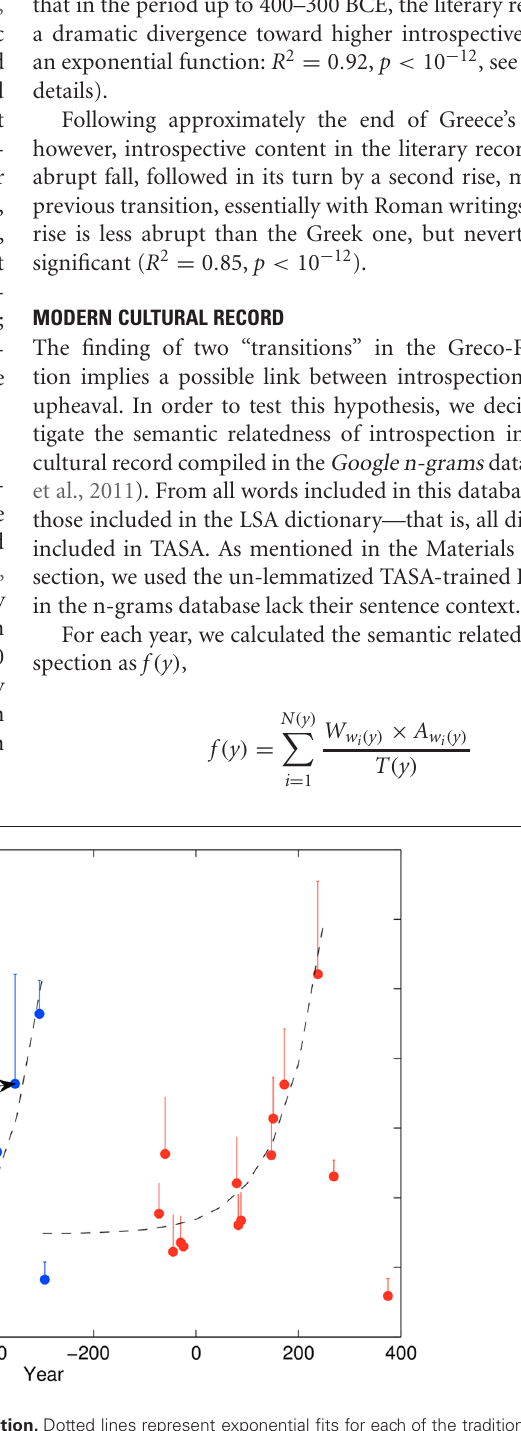
Frontiers in Integrative